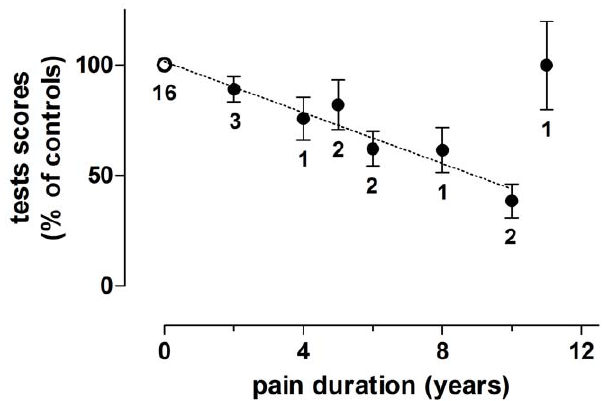
Figure 1. Pain duration dependent decrease in cognitive performance. The figure visualized the pain duration dependent decrease in cognitive performance. Test scores are depicted (ordinate) versus duration of pain in years (abscissa). Only the scores on those nine tests with p # 0.05, explaining test scores with predictors ‘pain duration’ are given (see Table 4 lower panel, model 4: ‘pain duration’). The mean of the scores of the controls (with pain duration zero) on each of the nine tests was taken as 100%. For those test where an increase in test score indicated a decrease in performance, the inverse of the raw scores was taken. The percentage of the test scores of each individual subjects was calculated. The mean and SE of all these percentages (so of all subjects on all nine tests) are shown. For each point the number of subjects is indicated. Remarkable is that the patient that had pain duration of 11 years had a mean test score on the nine tests comparable to the controls. This patient was a young patient of only 29 years